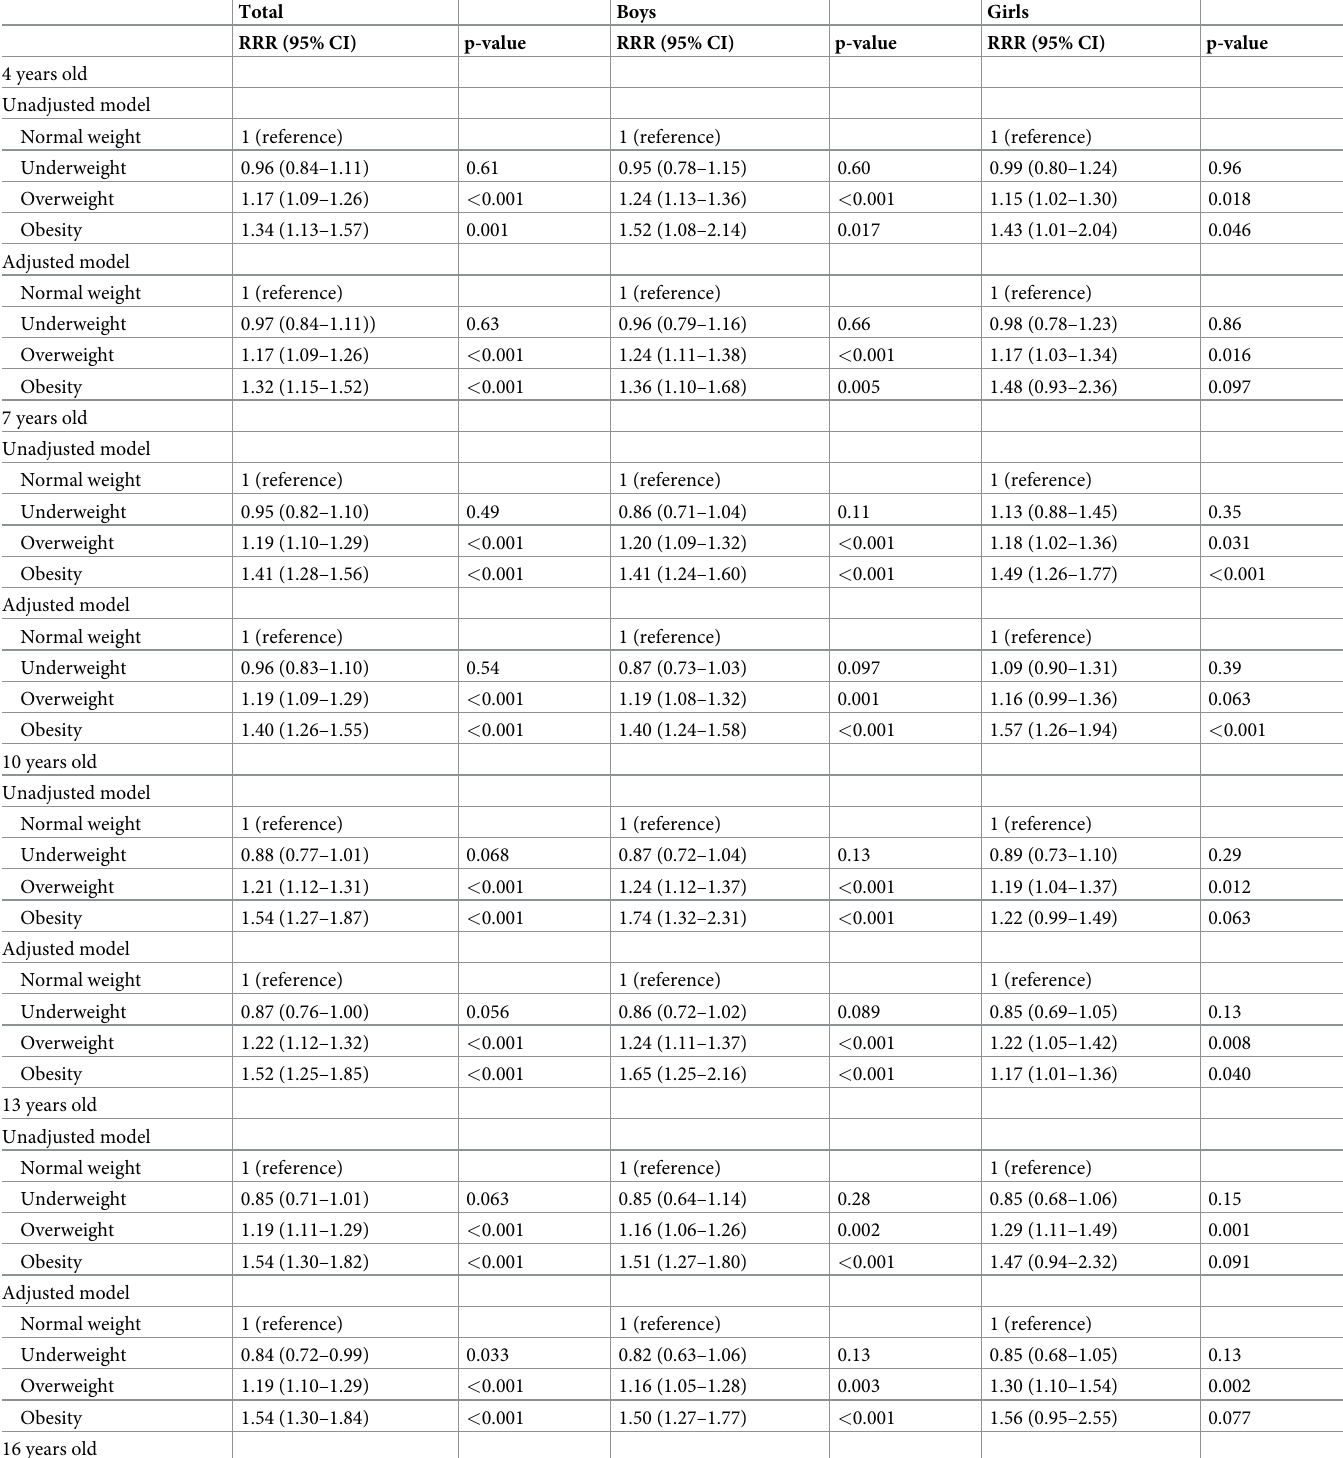
Table 3. Relative-risk ratios (RRR) for 4, 7, 10, 13, and 16-year old children to be classified as underweight, overweight or obese as compared to normal weight, per 1 unit increase in maternal body mass